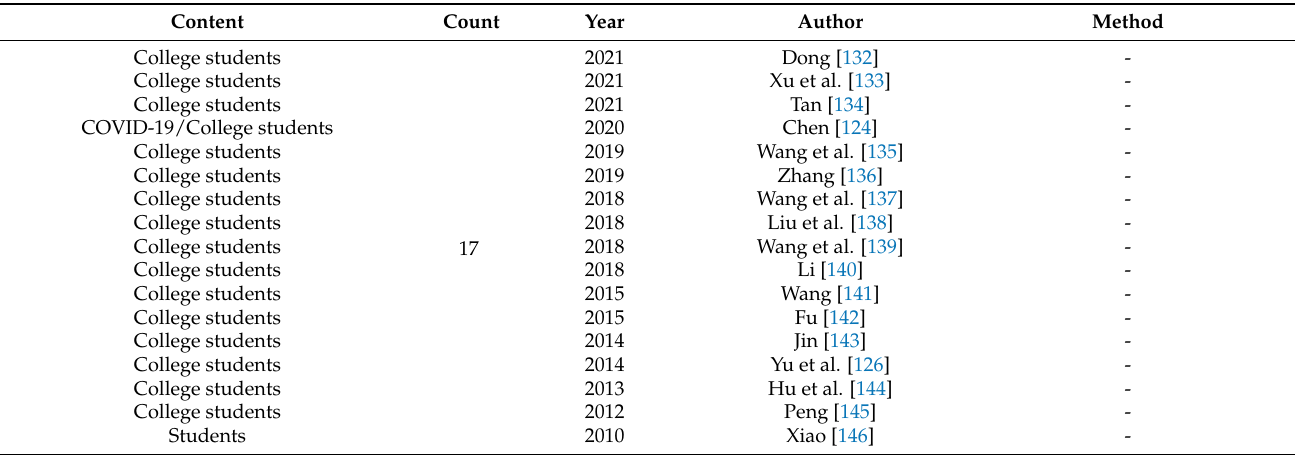
Table 4. Statistics on clusters of population and healthy social mentality in the CNKI before 1 April 2022 (generated by the